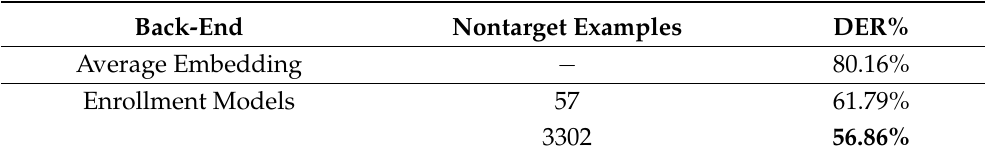
Table 1. Experimental results on RTVE 2020 Multimodal Diarization test set, showing DER%. These results were obtained to compare the back-end approach proposed and the cosine baseline. The best result is marked in